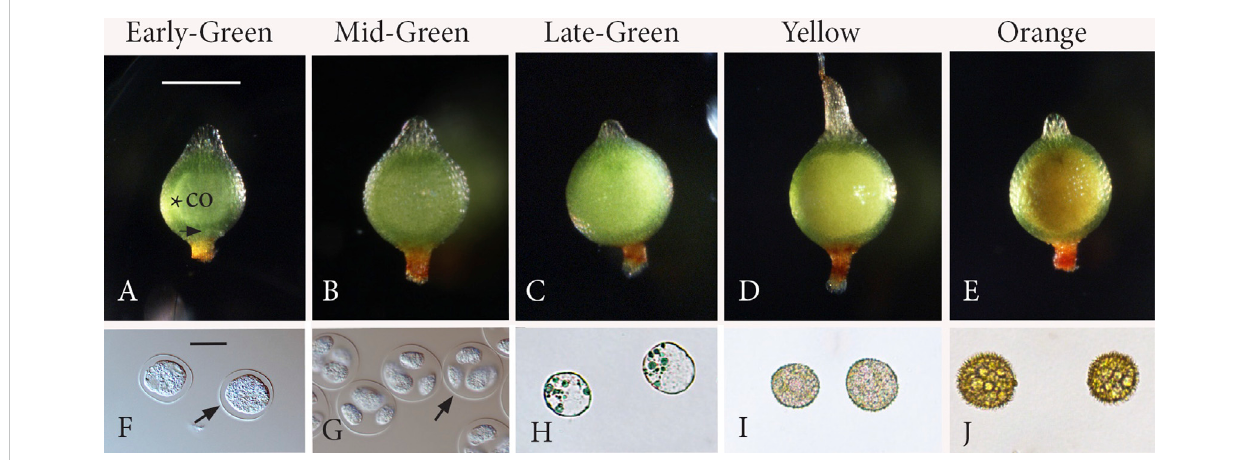
FIGURE 1 Fivestagesofsporogenesis.Capsules (A − E) andcorrespondingsporecontent (F − J) . (A) Stage1: Early-Green .Greenexpandingcapsulethatcontains a central columella (co) surrounded by a narrow ring of archesporial tissue (*). Stomata (arrow). (B) Stage 2: Mid-Green . Following meiosis, the spherical capsuleisfullyexpandedwithalargercentralmassoftetradsinthelocularmatrix,obscuringthecolumellafortheremainderofdevelopment. (C) Stage3: Late-Green . Green capsules with an expanded inner whitish mass of free spores that are greatly enlarged compared with those in tetrads in Figures 1B,G. (D) Stage 4: Yellow .Spores occupy ayellowmass that fi llsthecenterof thecapsule. (E) Stage 5: Orange . Fully developed spores comprise acentral orange mass in mature capsules. (F) Stage 1: rounded spore mother cells surrounded by the thickened extraprotoplasmic matrix inside the thin spore mother cell (SMC) wall (arrow). (G) Stage 2: round tetrads surrounded by the SMC wall (arrow) with nascent spores suspended in the extraprotoplasmic matrix and separated by an intersporal matrix. (H) Stage 3: young rounded free spores. (I) Stage 4: spores with a developing perine. (J) Stage 5: mature spinose spores. Scale bars: (A − E) = 500 μ m; (F − J) = 20 μ